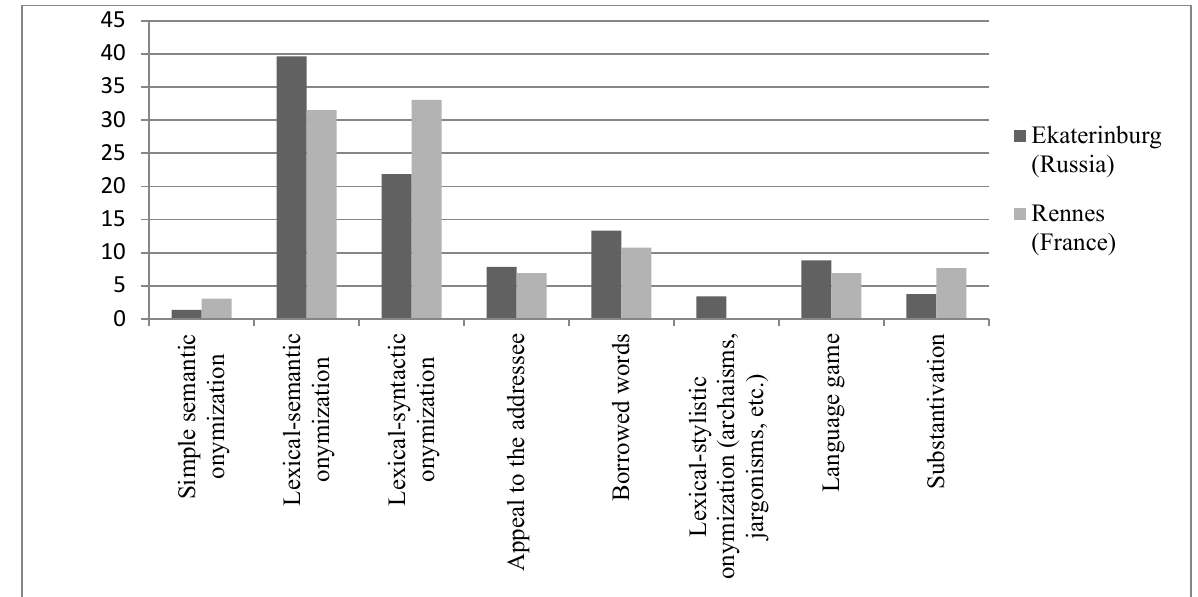
Figure 1 – Ways of ergonym formation in Ekaterinburg and